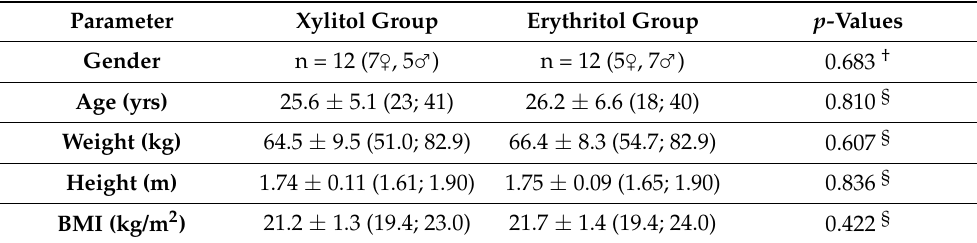
Table 3. Participants’ baseline characteristics (mean ± SD